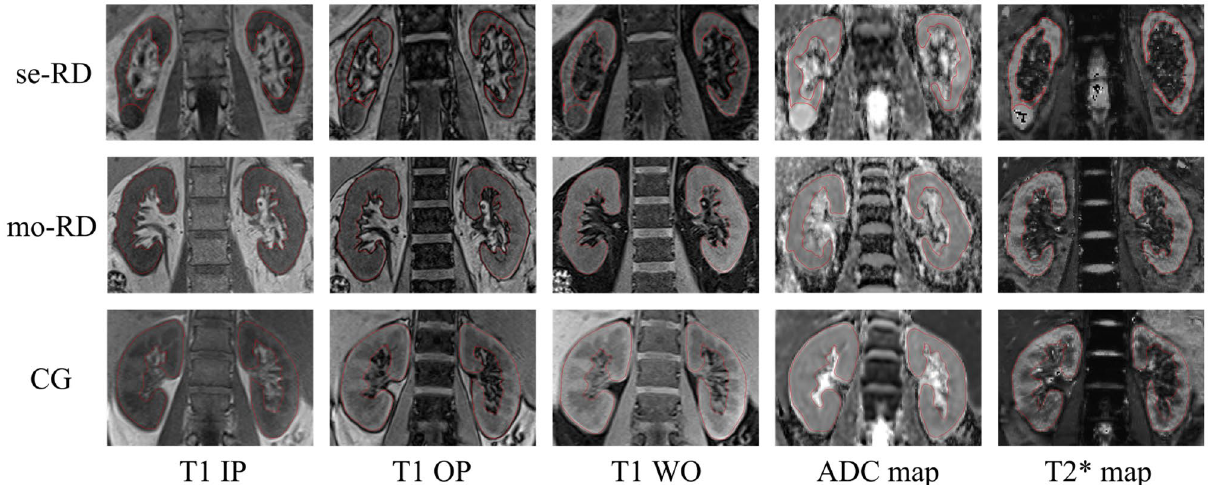
Figure 5. A method to set the region of interest (ROI) for each group and each image. ROIs were manually drawn on the contour lines of both kidneys, as shown by the red curves (avoiding the cystic area). ADC apparent diffusion coefficient, IP in-phase, OP opposed-phase, WO water-only. Severe renal dysfunction group (se-RD, estimated glomerular filtration rate [eGFR] < 30 mL/min/1.73 m 2 ), moderate renal dysfunction group (mo-RD, 30 ≤ eGFR < 60 mL/min/1.73 m 2 ), and control group (CG, eGFR ≥ 60 mL/min/1.73 m 2